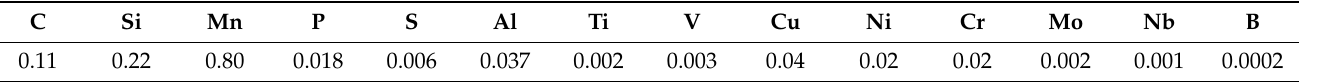
( d ) Figure 3. Pull ‐ off testing on coated samples after 720 h of exposure in a salt spray chamber according to ISO 4624. Samples are represented as A1 ( a ), A2 ( b ), B1 ( c ) and B2 ( d ), according to the Table 2. FEI Quanta 250 FE Scanning Electron Microscope equipped with an Oxford PEN ‐ TAFET detector (Oxford Instruments, Belfast, UK) was utilized for the microstructure and the surface morphology scan of IR and air ‐ dried waterborne coating systems. Three